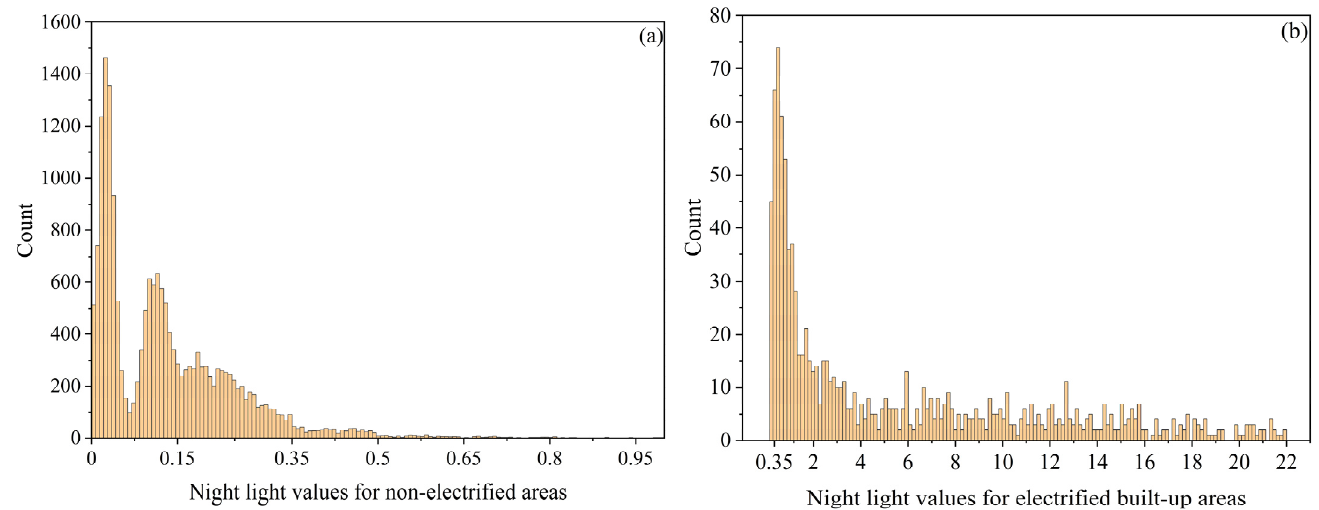
Figure 2. Histogram of night-light values in non-electrified areas ( a ) and electrified built-up areas